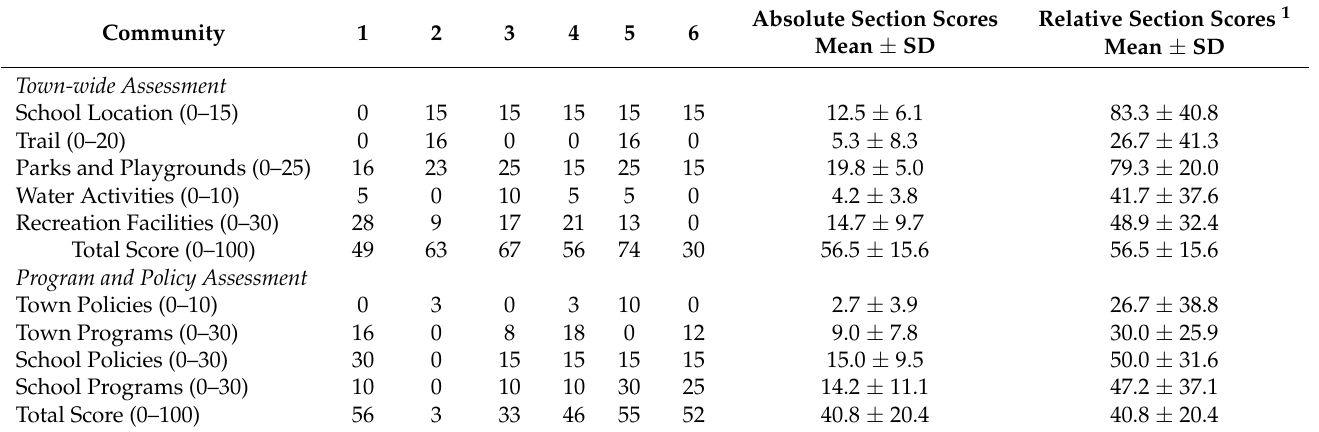
Table 3. Town-wide and program and policy assessment section scores by community